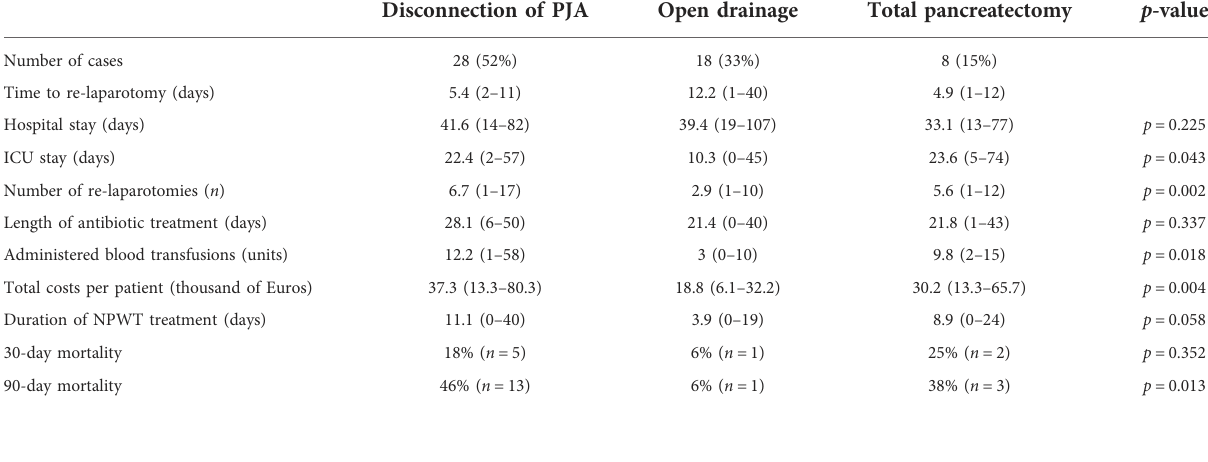
TABLE 2 Monitored data of the patients with Grade C postoperative pancreatic fi stula indicated for re-laparotomy. Disconnection of